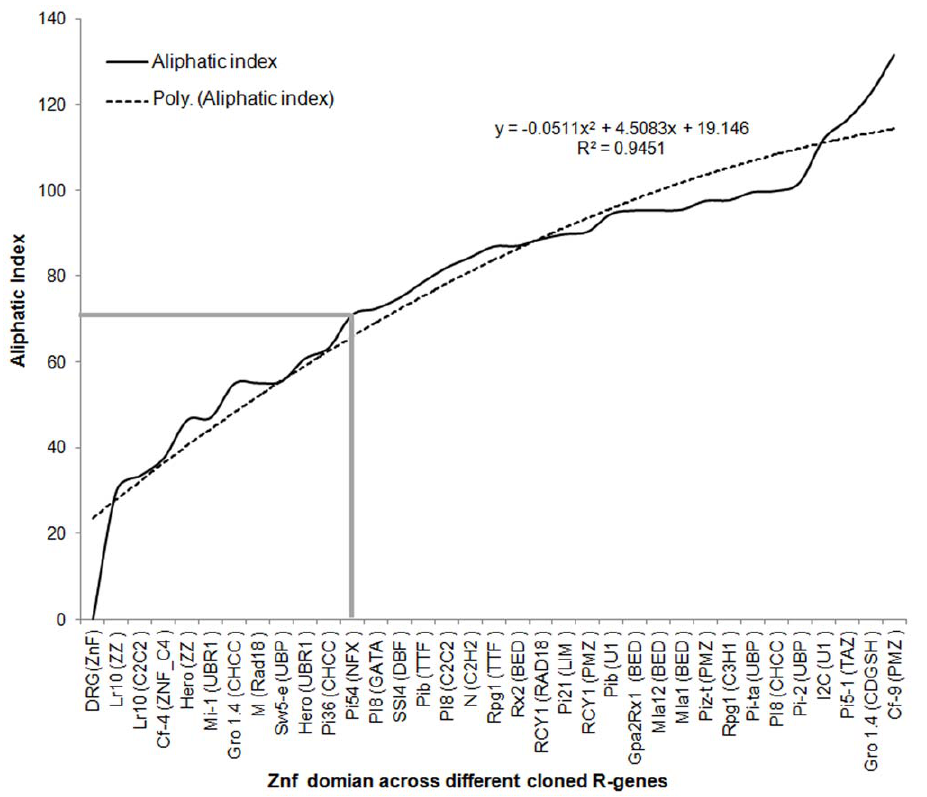
Figure 5. Aliphatic index profile of identified zinc finger domain across cloned R gene. The data of 26 zinc finger R genes with their zinc finger types were included in this analysis.